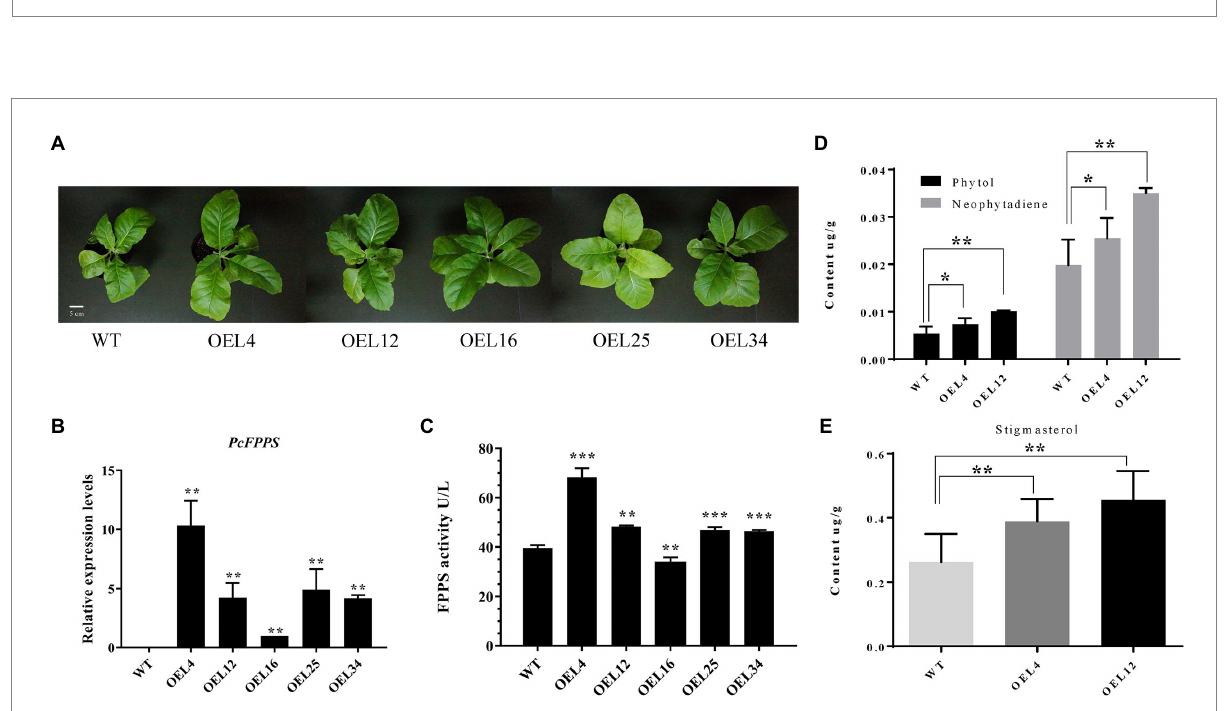
FIGURE 5 Overexpression of PcFPPS modulated the relative expression levels of PcFPPS and altered the endogenous terpenoid contents in transgenic tobacco plants. (A) Phenotypes of WT and transgenic tobacco plants. (B) Relative expression levels of PcFPPS in transgenic tobacco plants. (C) Activity of FPPS in WT and transgenic tobacco plants. (D) The content of phytol and neophytadiene detected in WT and transgenic tobacco OEL4 and OEL12. (E) The content of stigmasterol detected in WT, OEL4, and OEL12. Student’s t -test was performed to identify significant differences. One asterisk (*) indicates a significant difference (0.01 < p < 0.05) and two/three indicate a very significant difference ( p < 0.01). Scale bars = 5